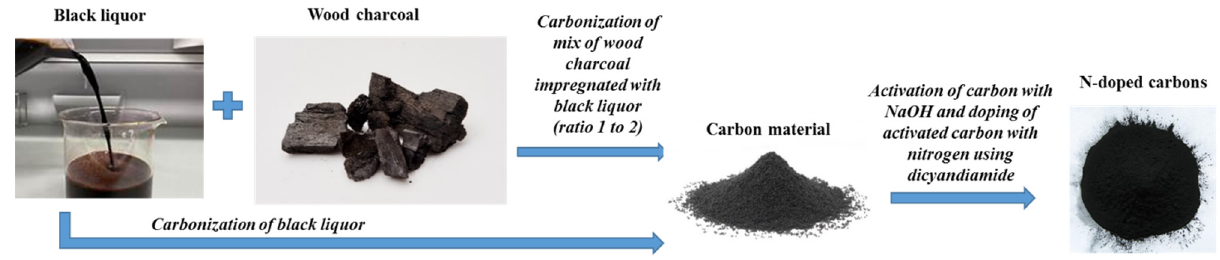
Figure 1. Carbon-based materials fabrication scheme.